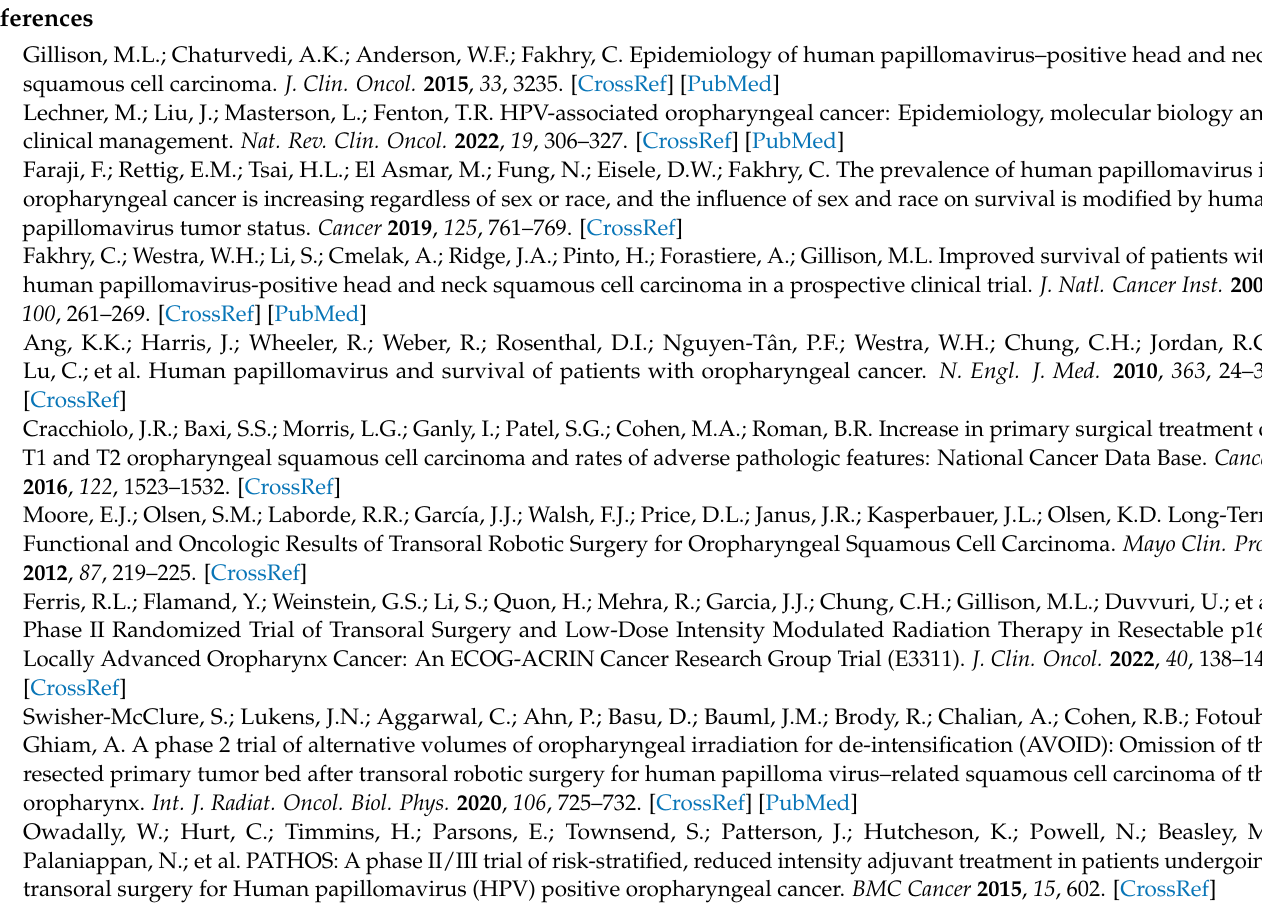
Radiotherapy; Table S2: Cox Proportional Hazards Analysis of Patients with HPV-OPC; Table